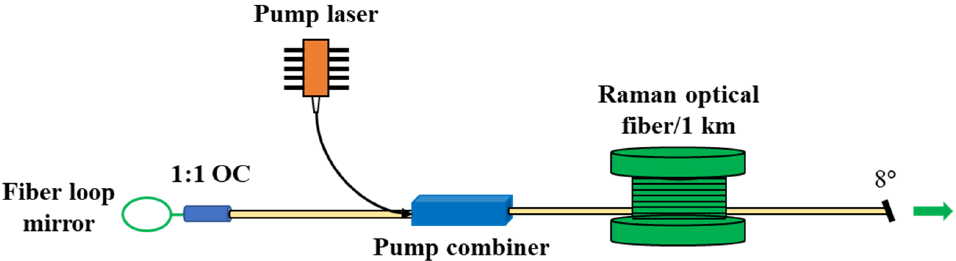
Figure 1. Structure of the multi ‐ wavelength random Raman fiber laser.